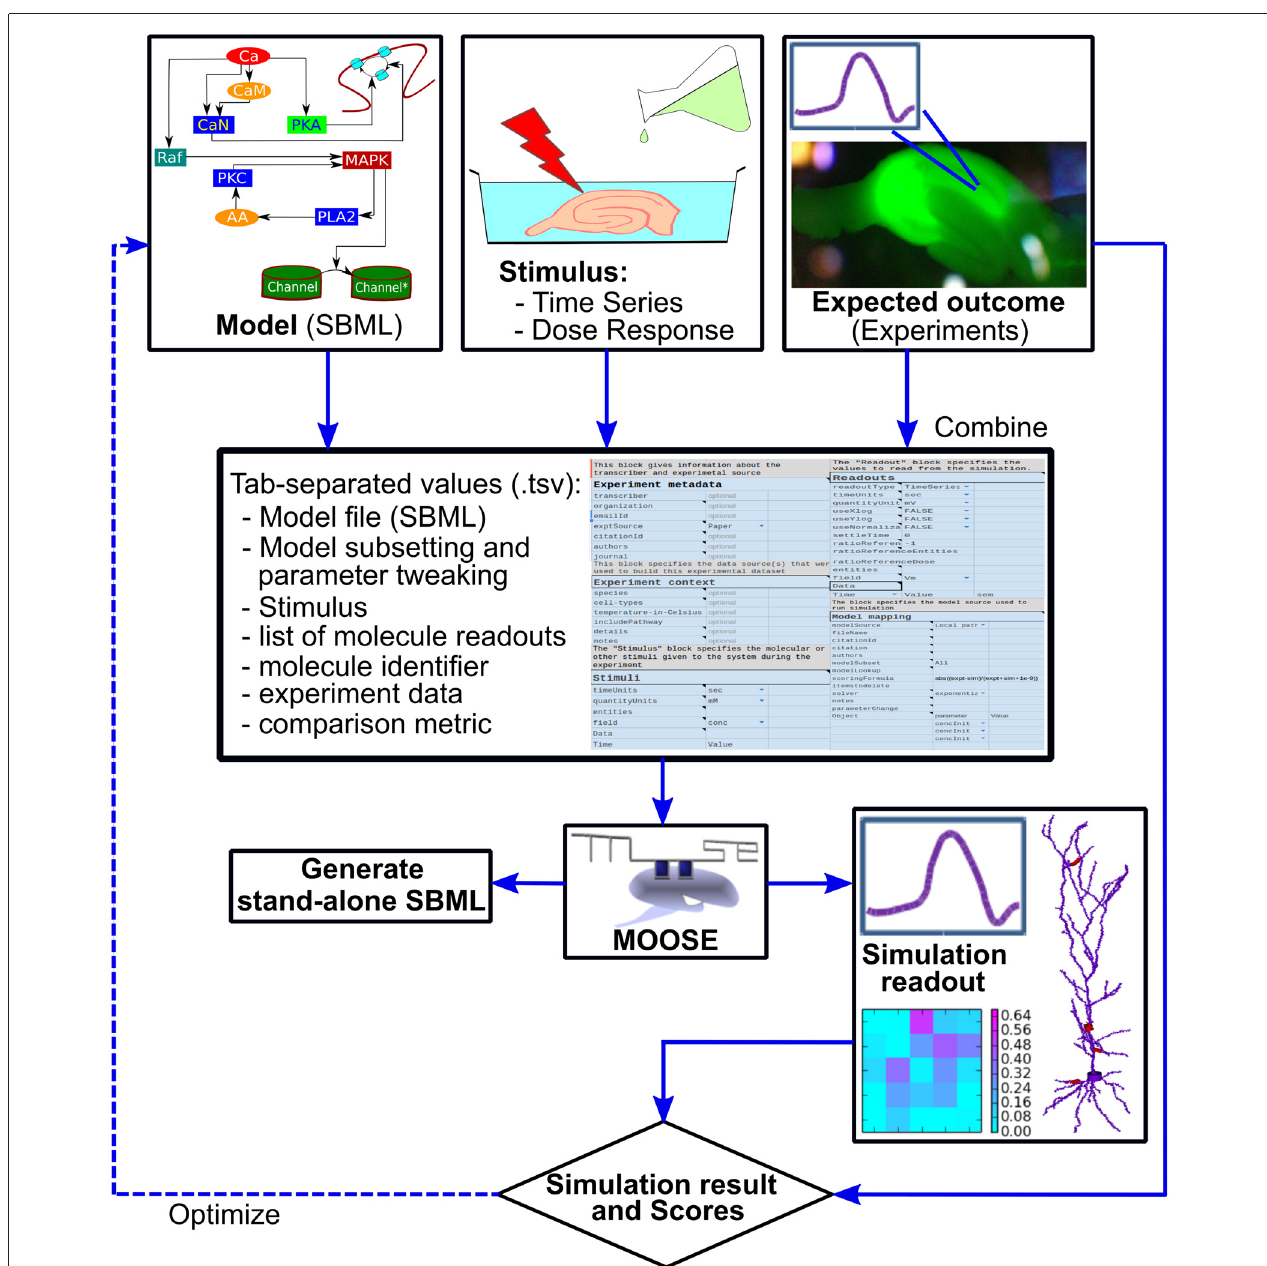
FIGURE 2 | Block diagram of the FindSim pipeline. Top: the inputs to the pipeline. Left: Model specification, typically in SBML. Middle: experimental stimuli. Right: experimental outcomes. Middle from top: the two experimental inputs and the metadata for how to apply these to the model are specified in a structured experiment definition in a tab-separated text file (.tsv file). This may be manipulated by an enhanced spreadsheet, or through a GUI. Below: the experiment definition and model are read in and executed by a Python/MOOSE script. This may either run the simulation and compare with experiment (right, lowermost) or emit SBML output